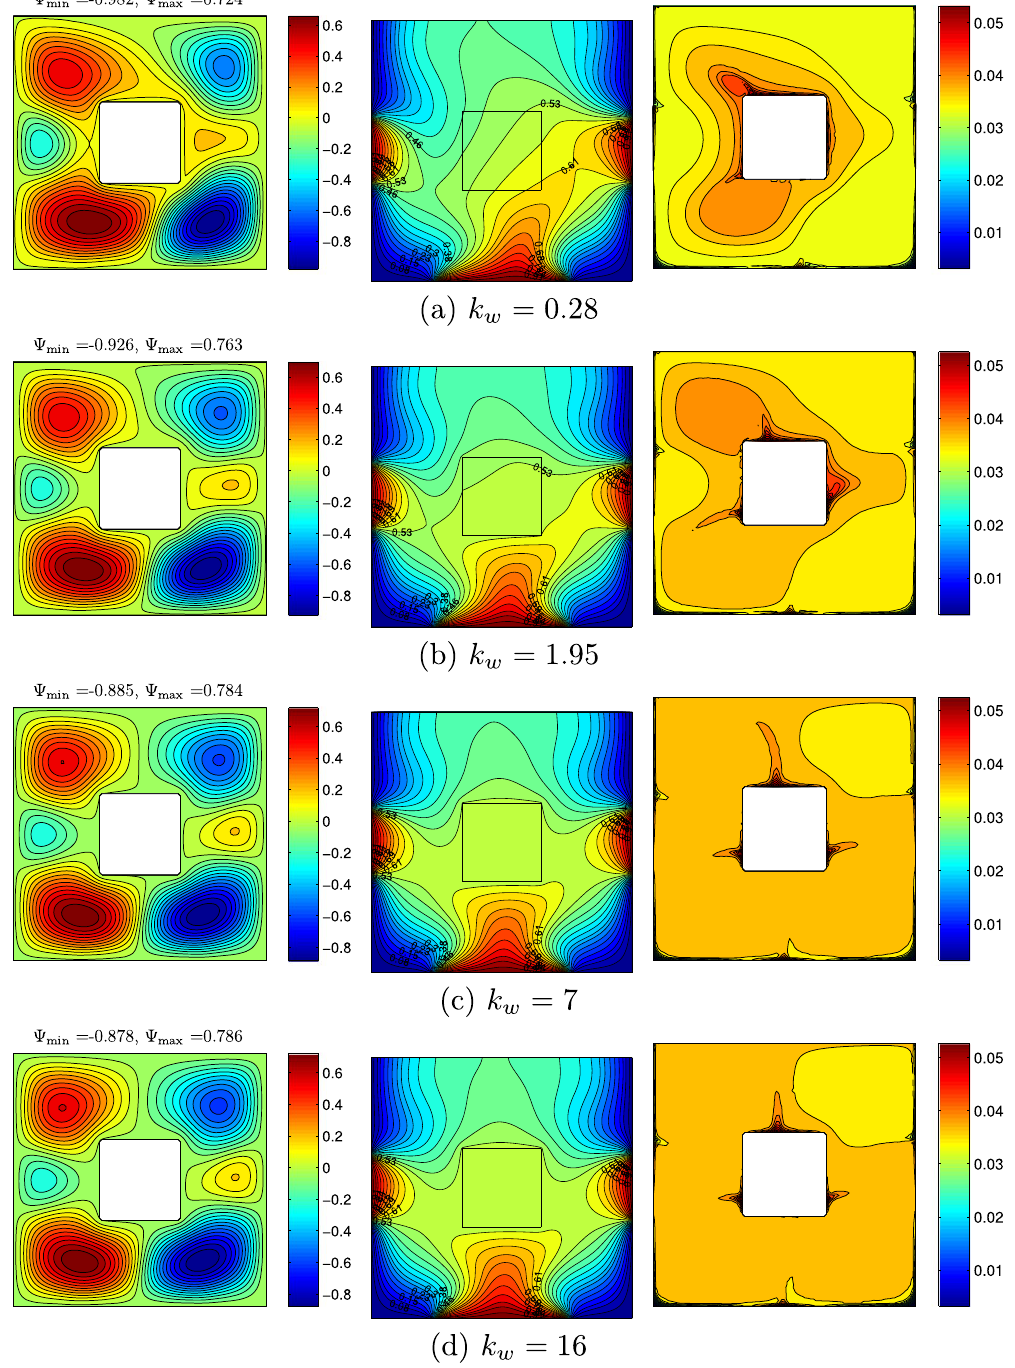
Figure 16. Variation of the streamlines (left), isotherms (middle), and nanoparticle distribution (right) evolution by thermal conductivity of the conductive inner block ( k w ) for Ra = 10 5 , φ = 0.02, Ha = 15 and D =